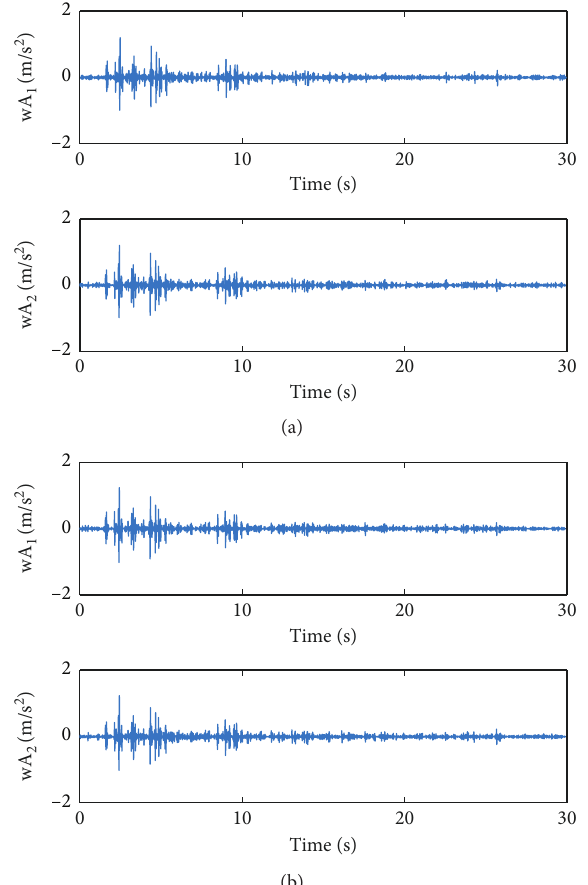
Figure 12: Wavelet detailed components of the simulated structure under E1-Centro earthquake wave. (a) Case 1. (b) Case 2.